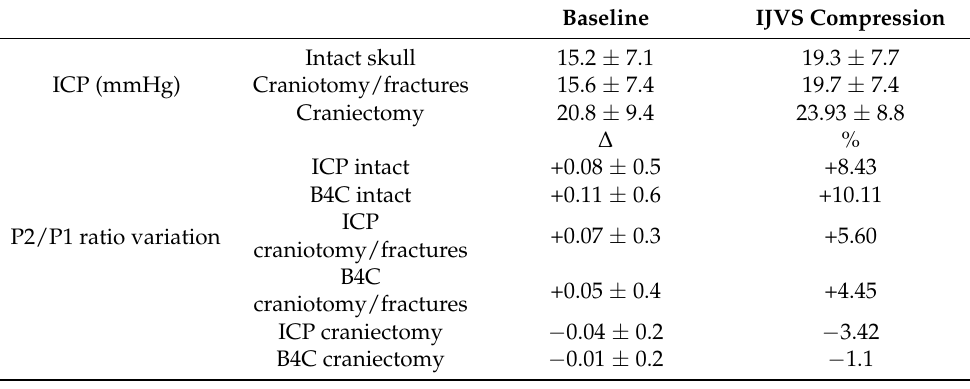
Figure 5. Pearson’s correlation analysis for P2/P1 ratio (up) and TTP (down) separated between groups according to cranial status.